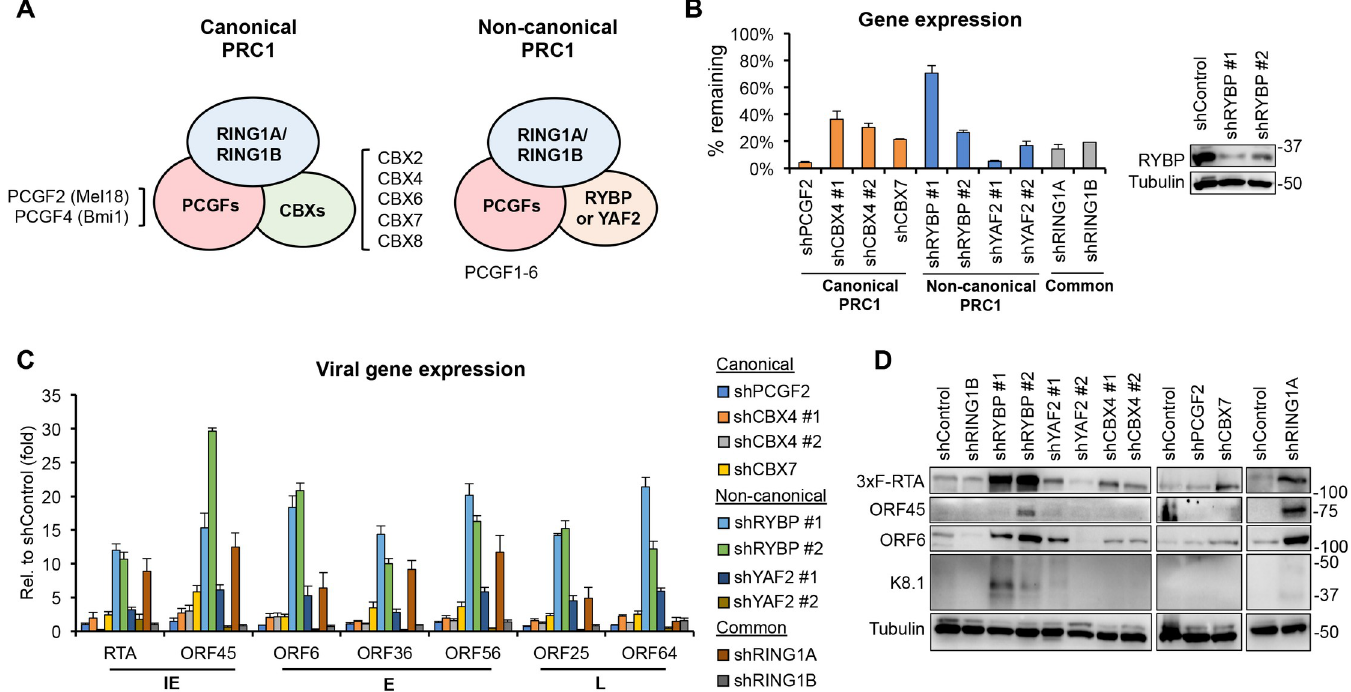
Fig 1. Analysis of viral gene expression changes upon shRNA knockdown of PRC1 factors during primary KSHV infection. (A) Components of the canonical and non-canonical Polycomb Repressive Complex 1. (B-D) SLK cells were transduced with lentiviruses expressing shRNAs that were specific for different subunits of PRC1. Three days post-transduction, the cells were infected with KSHV for 72 hours. (B) RT-qPCR and immunoblot analyses of the expression of PRC1 factors after shRNA knockdown. The percentage of remaining transcript expression is shown relative to the shControl. (C) RT-qPCR analysis of the expression of viral genes including immediate early (IE), early (E), and late (L) genes. (D) Immunoblot analysis of viral protein expression. Tubulin was used as a loading control.